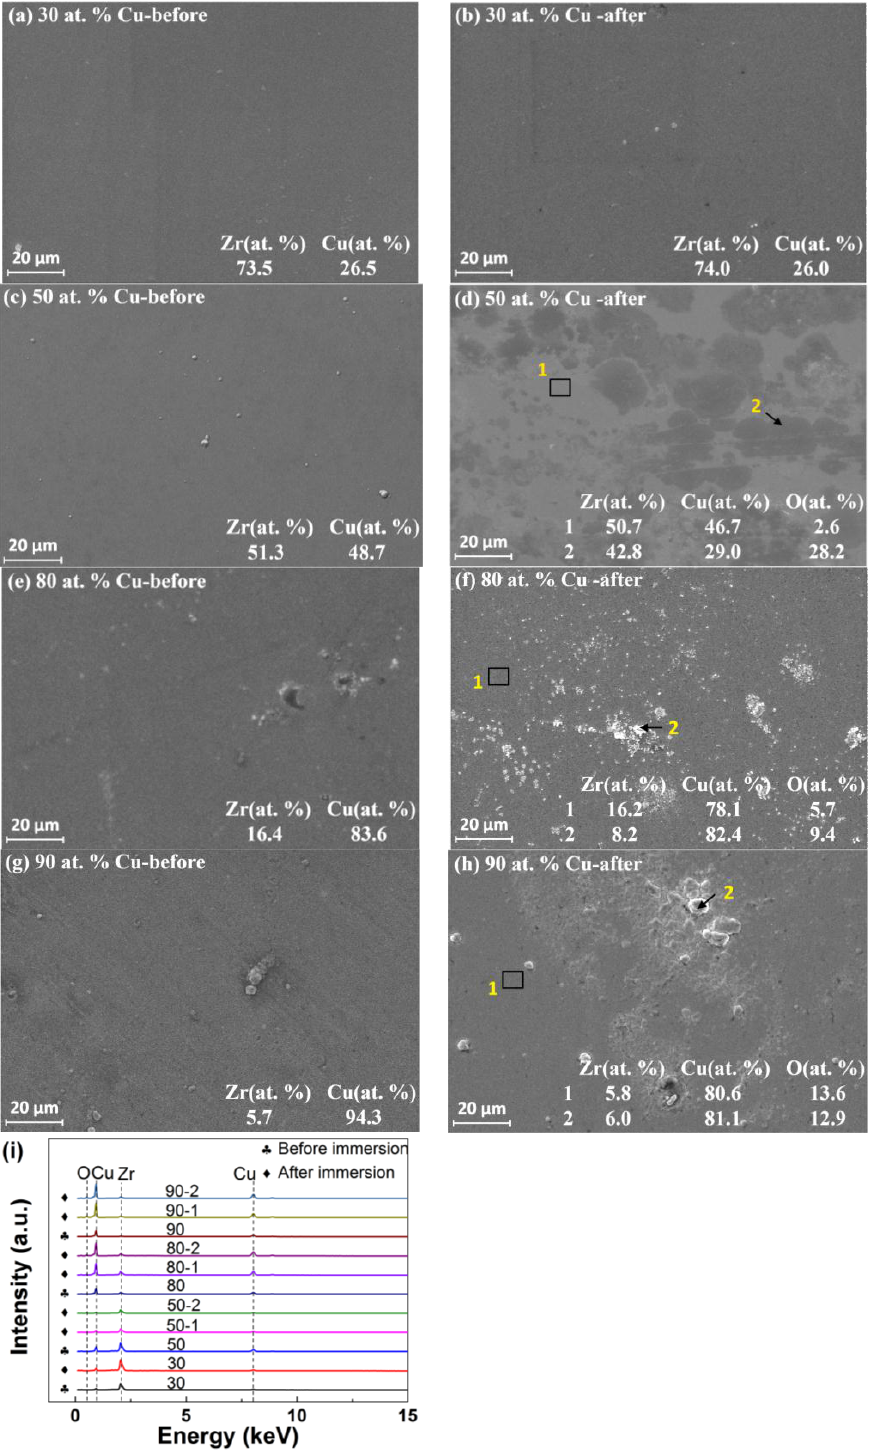
Figure 6. SEM images and energy dispersive analysis spectroscopy (EDS) results of Zr-Cu glassy coatings before and after corrosion for 16 h in 0.01 M deaerated H 2 SO 4 solution at ambient temperature; ( a , b ) Zr-30 at.%Cu; ( c , d ) Zr-50 at.% Cu; ( e , f ) Zr-80 at.% Cu; ( g,h ) Zr-90 at.% Cu; ( i ) EDS.